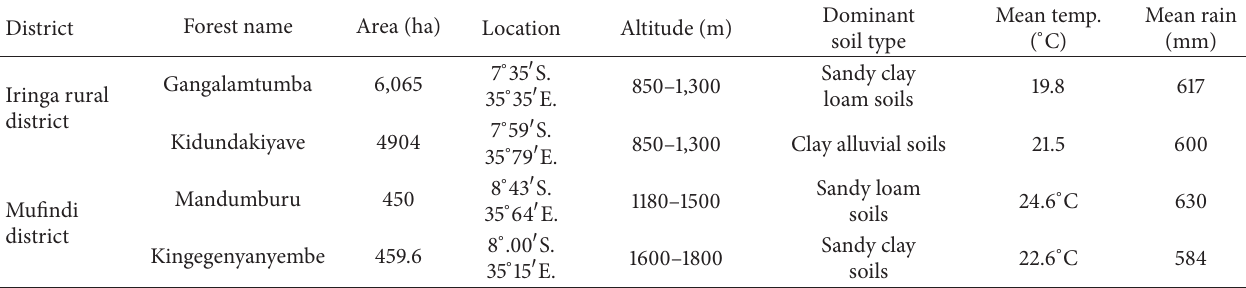
Table 1: Biophysical and climatic characteristics of studied miombo forest reserves by 2011 [14]. District